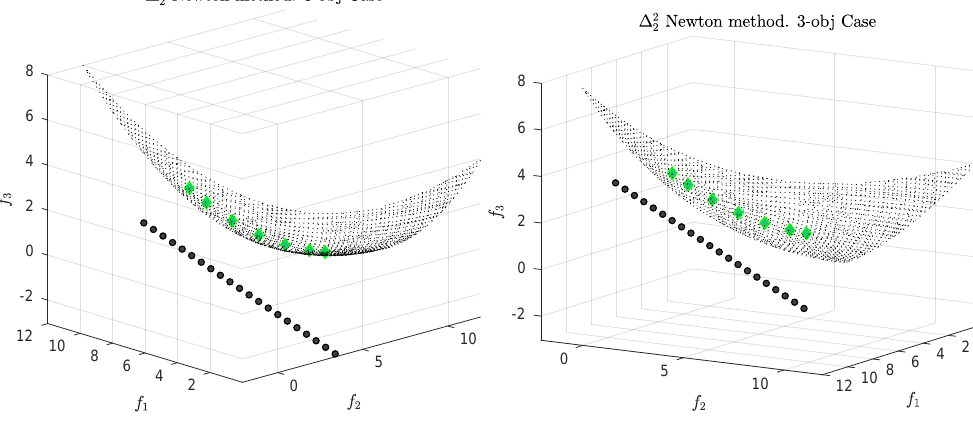
Figure 14. Result of the ∆ 2